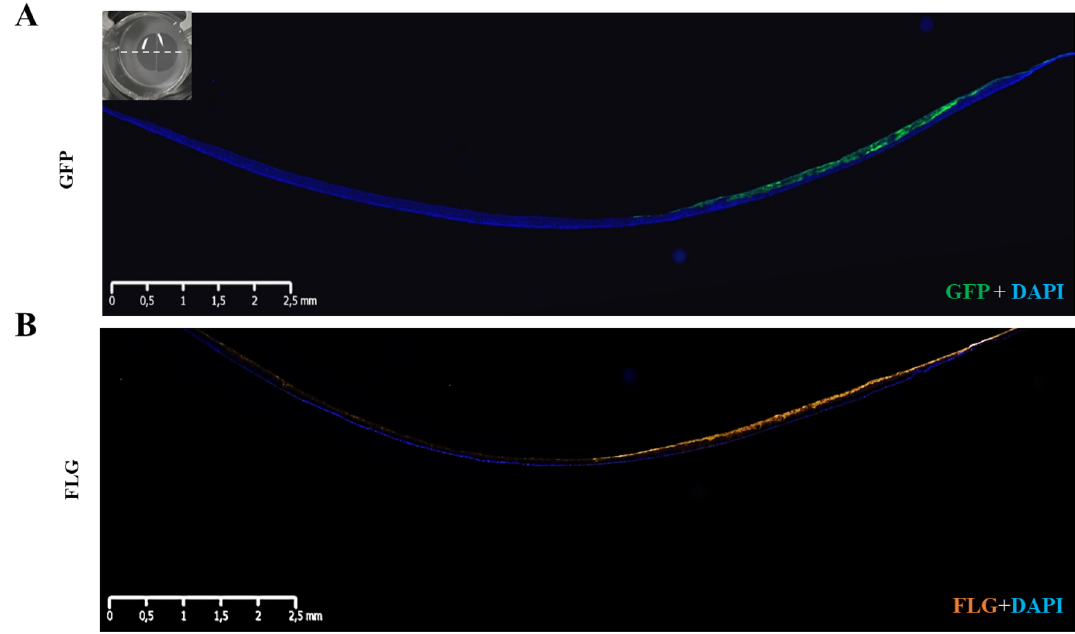
Figure 6. Expression of FLG and GFP in the reconstructed epidermis created via patterned bioprinting with shLUC and shFLG cell populations. ( A ) GFP (green) and ( B ) FLG expression is only present on the shLUC half of the reconstructed skin. Images representative of 8